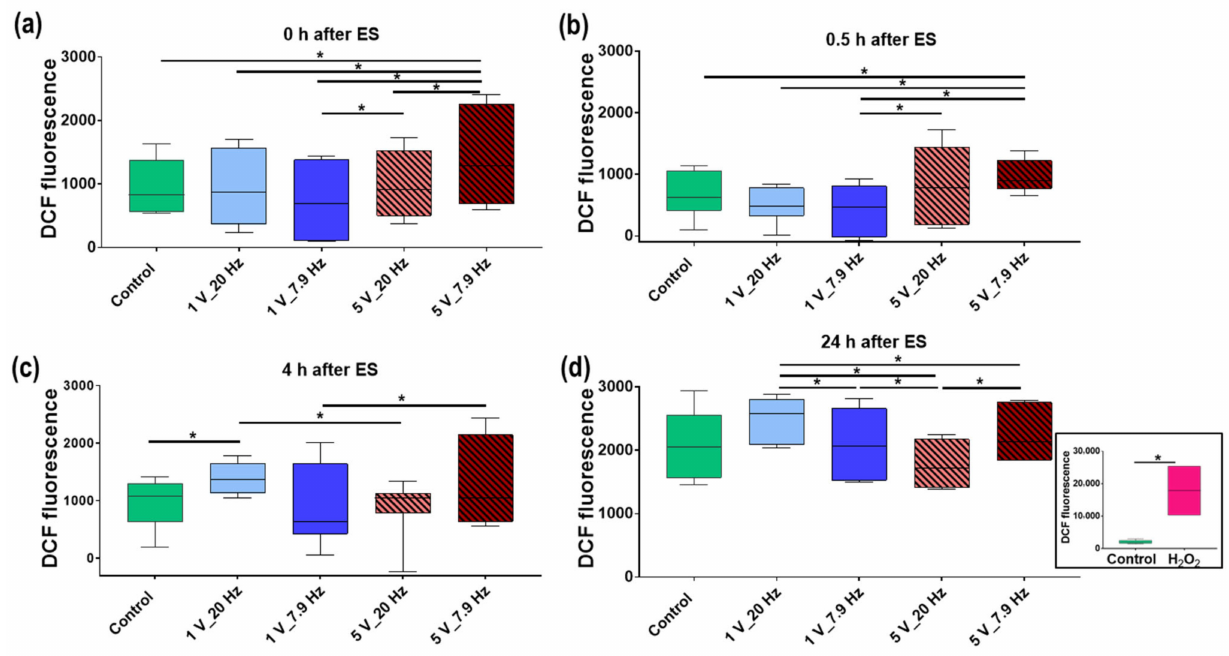
Figure 11. Reactive oxygen species (ROS) production in MG-63s after AC stimulation (10 min) over time ( a ) 0 h, ( b ) 0.5 h, ( c ) 4 h, and ( d ) 24 h. Note that 1 V settings did not change the intracellular ROS up to 0.5 h. In contrast, an increased ROS production could be observed after 5 V_7.9 Hz stimulation up to 0.5 h compared to Controls. At 4 h, a significant increase in ROS is then detectable in 1 V_20 Hz stimulated cells. However, after 24 h, all ROS levels were comparable to the Control. Note, the insert at 24 h plot ( d ) shows the maximum ROS production of cells treated with H 2 O 2 (positive check, 5%). (DCF-DA test, Tecan, n = 4, median ± min/max; one-way ANOVA posthoc uncorrected Fisher’s LSD, * p <